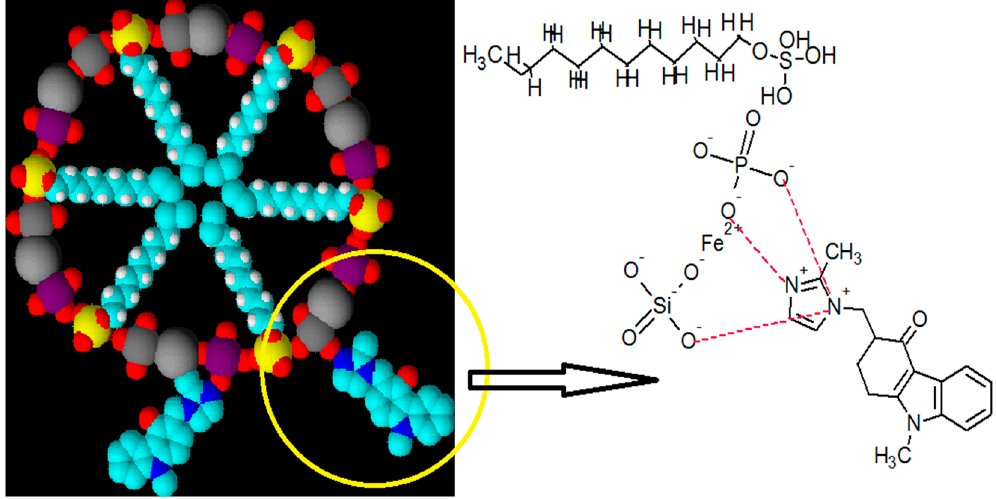
Figure 6. Possible mechanism of interaction of ondansetron SDS ‐ FeSP nanocomposites.